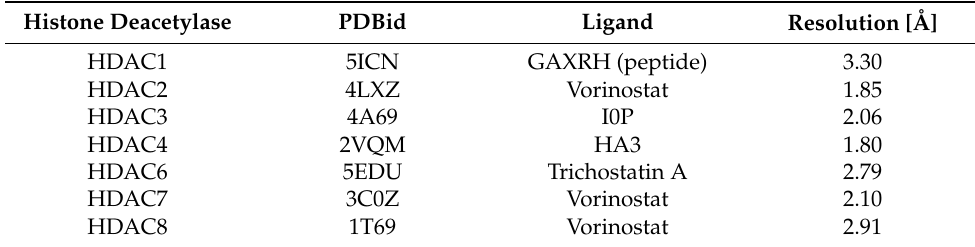
Table 5. PDBids of crystals used in docking